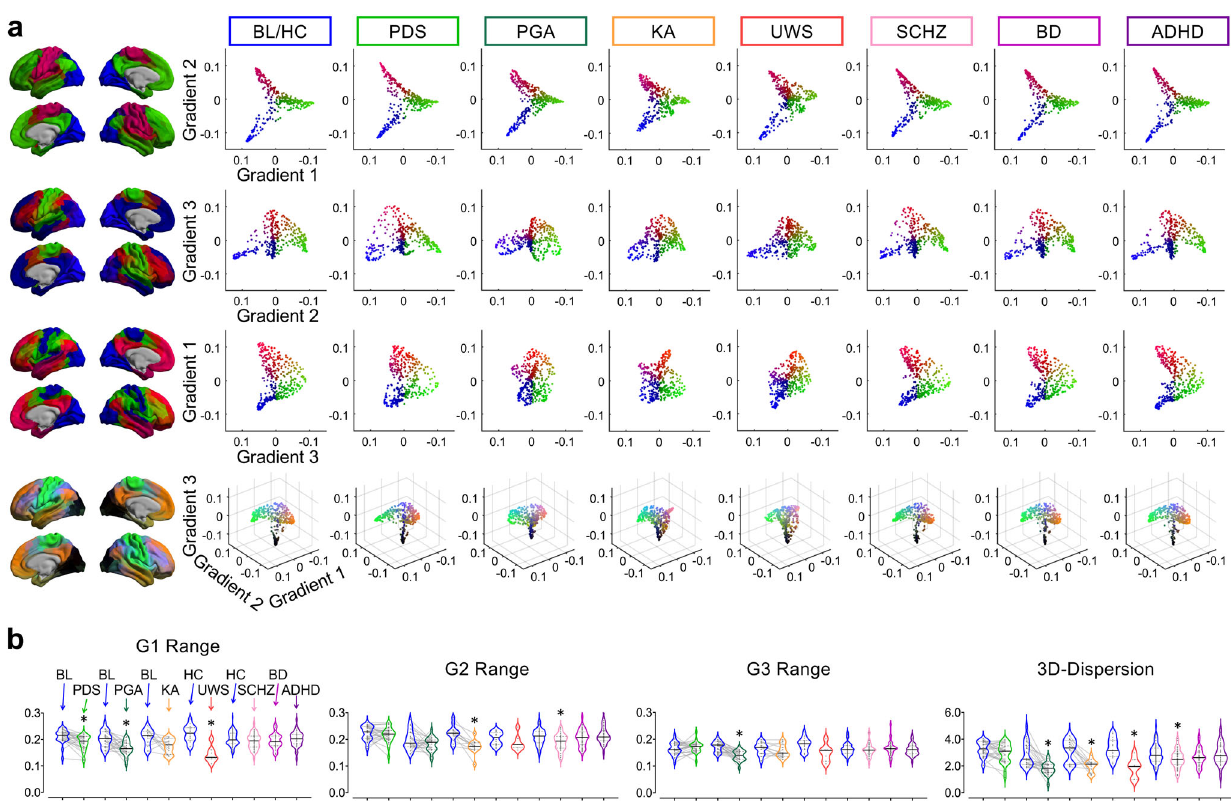
Fig. 3 | Cortical gradients in various states of consciousness. a Visualization of the fi rst three cortical gradients in 2D and 3D view. Diffusion map embedding was applied on the group-averaged functional connectivity matrices in conscious baseline and healthy controls (BL/HC; pooled across all datasets), propofol deep sedation (PDS), propofol general anesthesia (PGA), ketamine anesthesia (KA), unresponsive wakefulness syndrome (UWS), schizophrenia (SCHZ), bipolar dis- order (BD), and attention de fi cit hyperactivity disorder (ADHD). b Violin plots (median: solid line; quantiles: dash line) of the numerical ranges in each gradient, and 3D-dispersion (sum squared Euclidean distance of all regions to the global